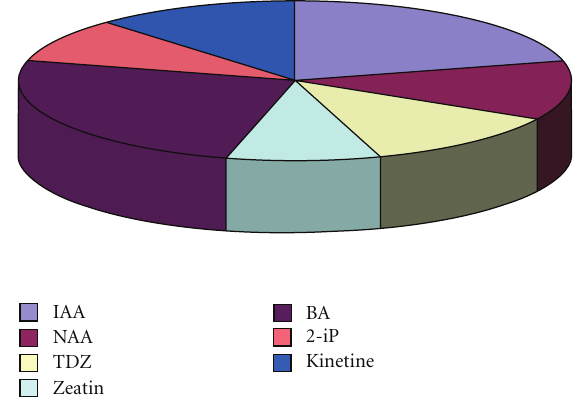
Figure 5: The relative shares of the most commonly used plant phytoregulators for Rhodiola bud and shoot induction in vitro .